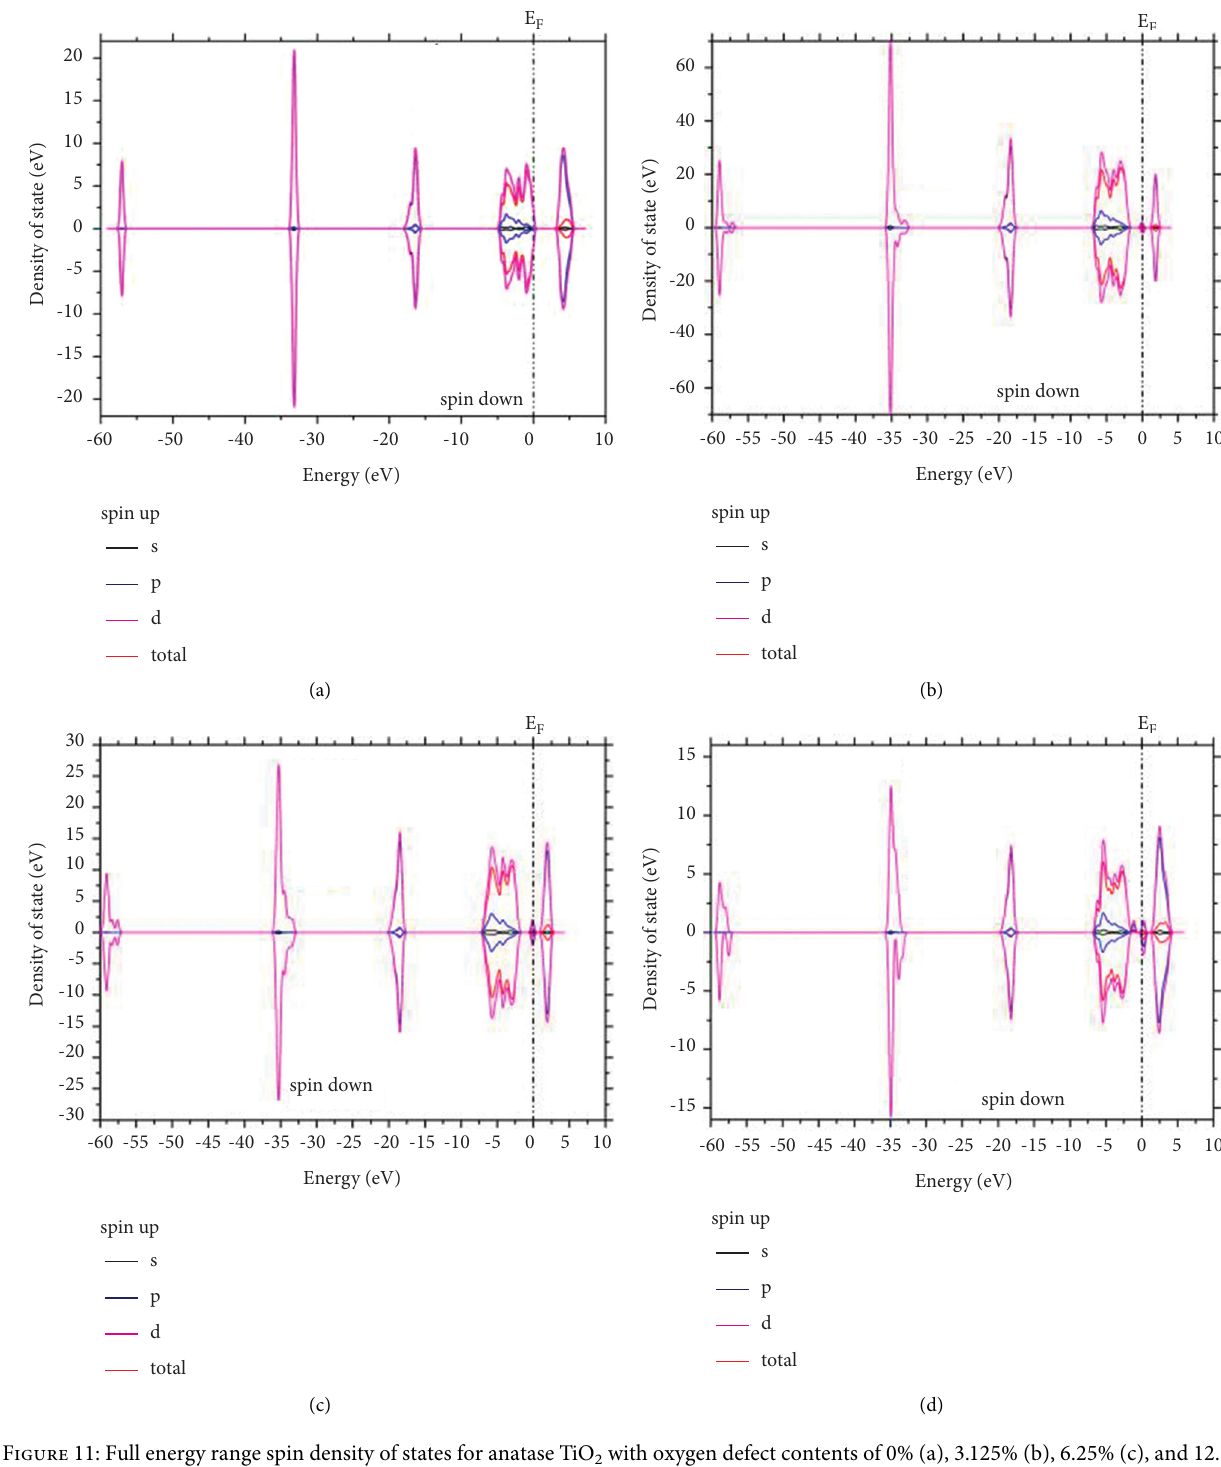
2 with oxygen defect contents of 0% (a), 3.125% (b), 6.25% (c), and 12.5%